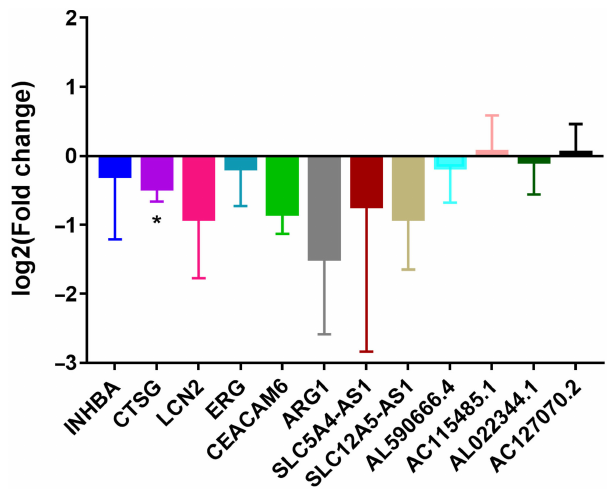
Figure 7. RT-qPCR results of DEmRNAs and DElncRNAs. DElncRNAs, differentially expressed long non-coding RNAs; RT-qPCR, real time quantitative polymerase chain